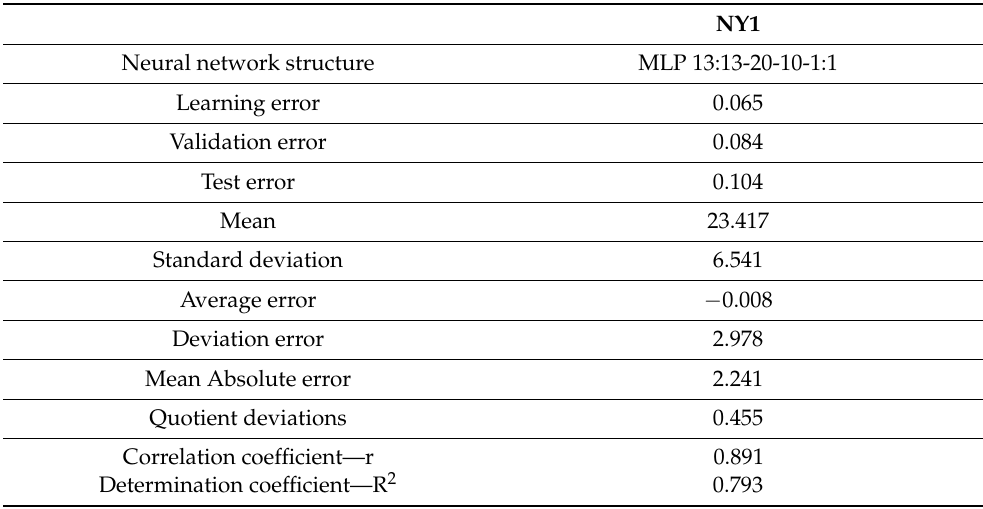
Table 3. Quality and structure of the constructed NY1 non-linear model.